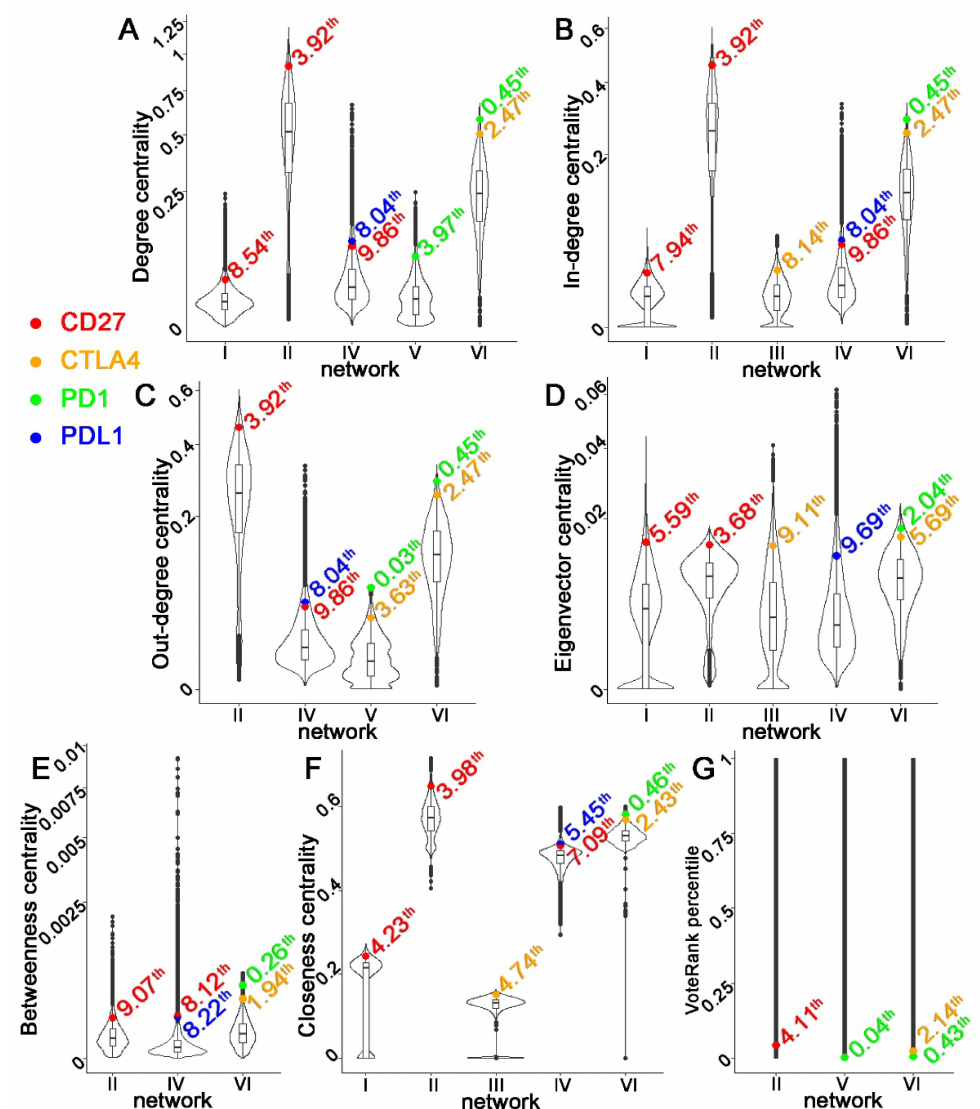
Figure 2. Distributions of centrality metrics in multi-omics networks with CD27, CTLA4, PD1 , or PDL1 ranked within the top 10th percentile. Each subplot represented a centrality metric. ( A ) Degree centrality. ( B ) In-degree centrality. ( C ) Out-degree centrality. ( D ) Eigenvector cen- trality. ( E ) Betweenness centrality. ( F ) Closeness centrality. ( G ) VoteRank centrality. Each violin plot showed the distribution of the centrality metric in one specific network: I. CNV-mediated gene expres- sion network in GSE28582; II. mRNA co-expression network in GSE28582; III. CNV-mediated gene expression network in GSE31800; IV. mRNA co-expression network in GSE31800; V. mRNA-mediated protein expression network in tumors of Xu’s LUAD patient cohort [39]; VI. mRNA co-expression network in tumors of Xu’s LUAD patient cohort